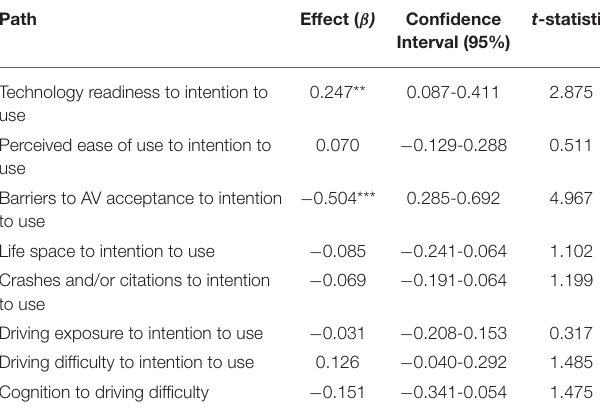
TABLE 4 | Statistical significance of path coefficients in the structural bootstrapped model ( N = 104).